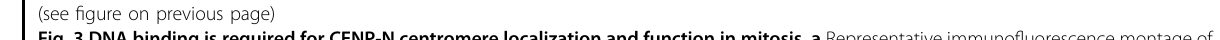
human and yeast CCAN complexes (Supplementary Fig.